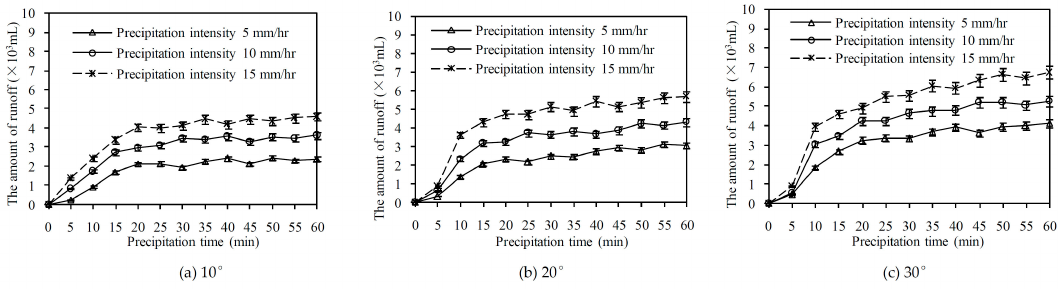
Figure 11. The relationship between surface runoff and precipitation intensity at rainfall duration up to 60 min on mound surfaces of three gradients.